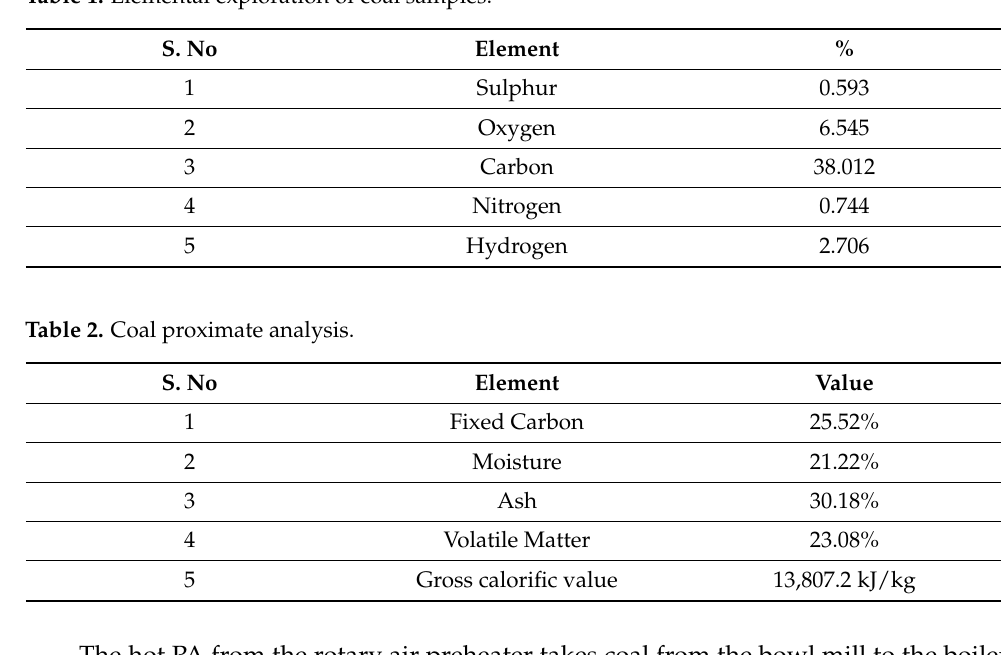
Table 1. Elemental exploration of coal samples.